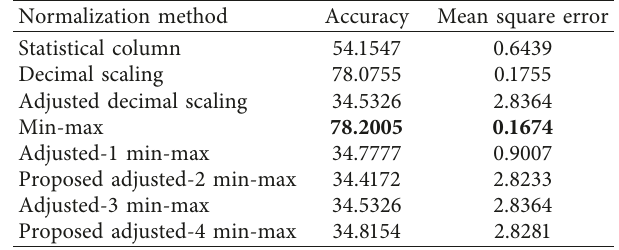
Table 7: Comparative results of prediction efficiency on working hour dataset yielded by every tested normalization method.